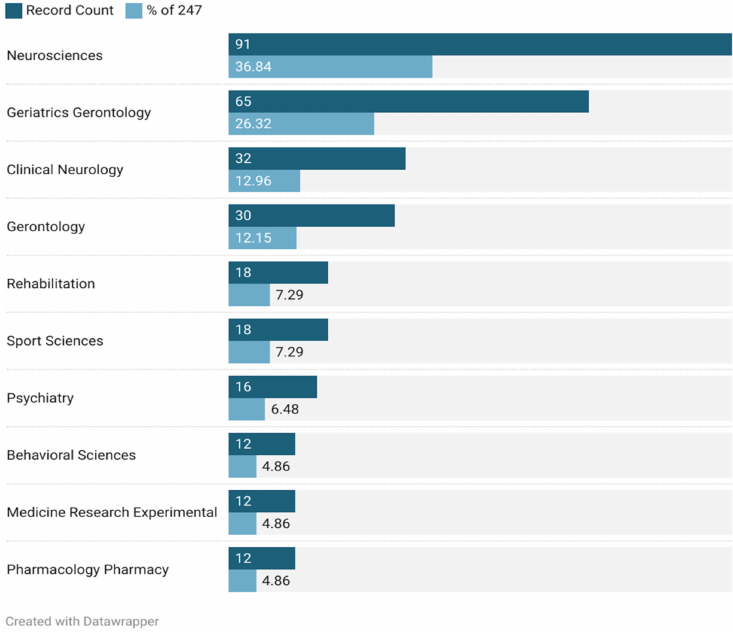
Figure 3. Top 10 categories of exercise research on AD in WOS.